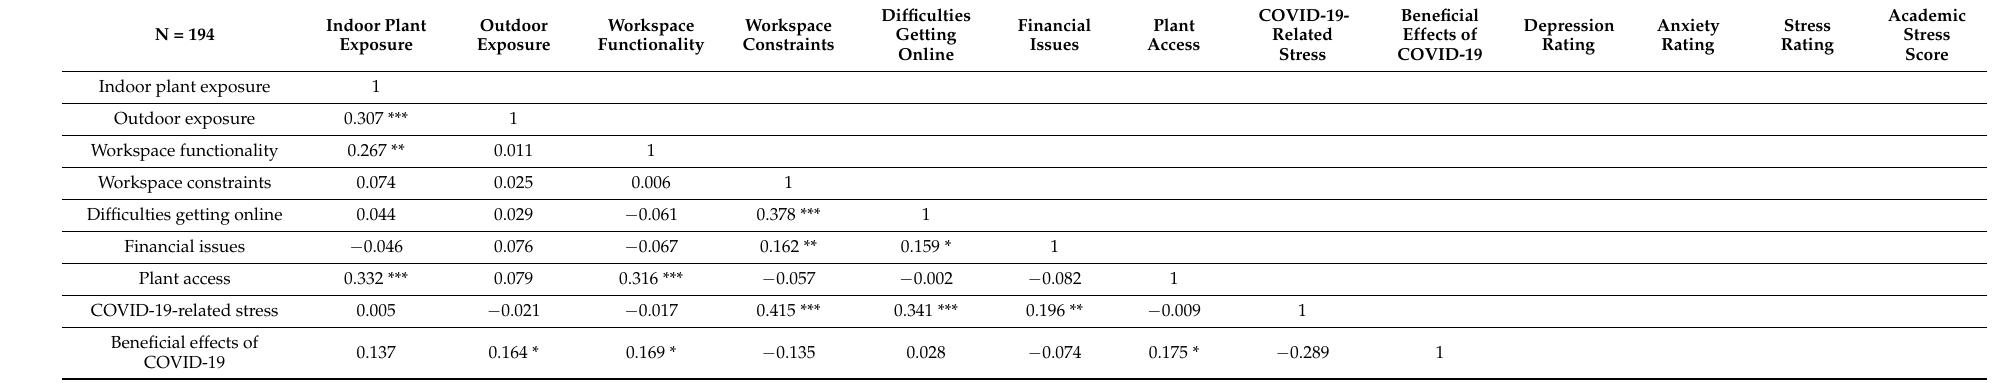
Table 6. Multivariate Correlation Analysis of DASA and survey categories for Fall. Spearman’s ρ correlation was performed to assess relationships between